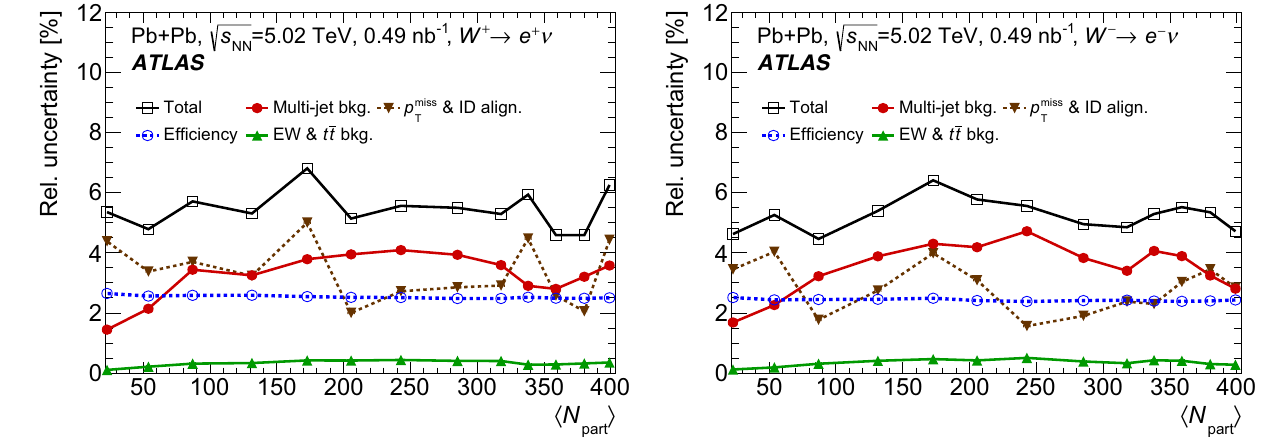
to electron efficiency corrections (“Efficiency”), p miss reconstruction T and ID align”), as well as and ID misalignment uncertainties (“ p miss T the uncertainties related to the estimation of EW and top-quark back- grounds (“EW and t ¯ t bkg”), are added in quadrature